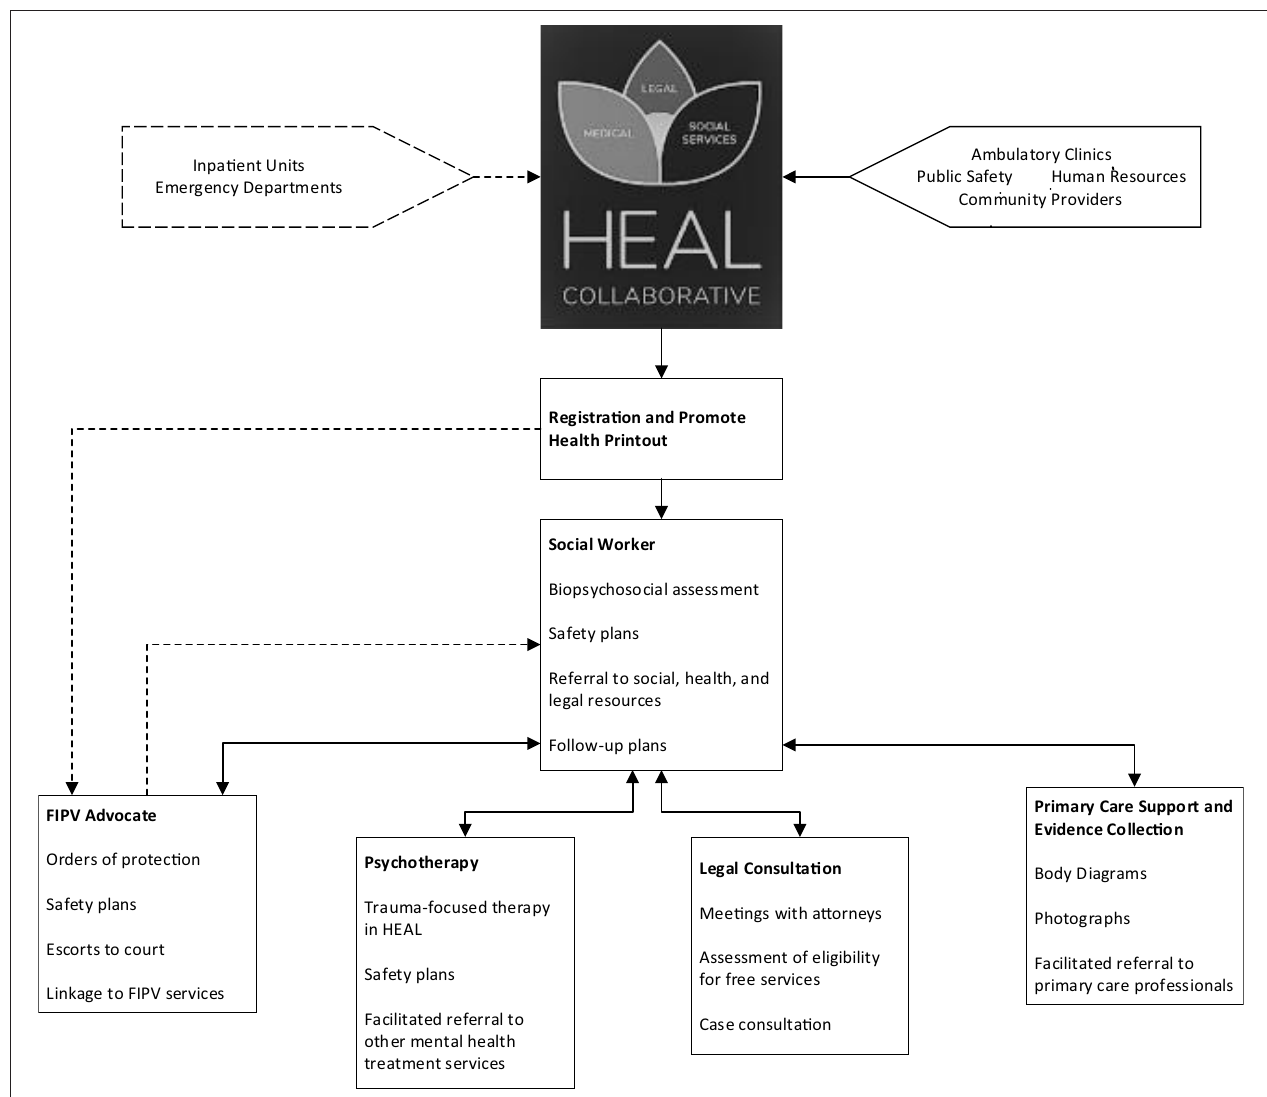
FIGURE 1 | Flowchart for HEAL Collaborative. FIPV: Family and Intimate Partner Violence.